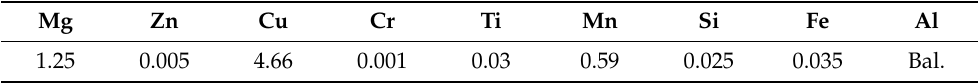
Table 1. Chemical compositions of 2524-T3 aluminum alloy (%, mass